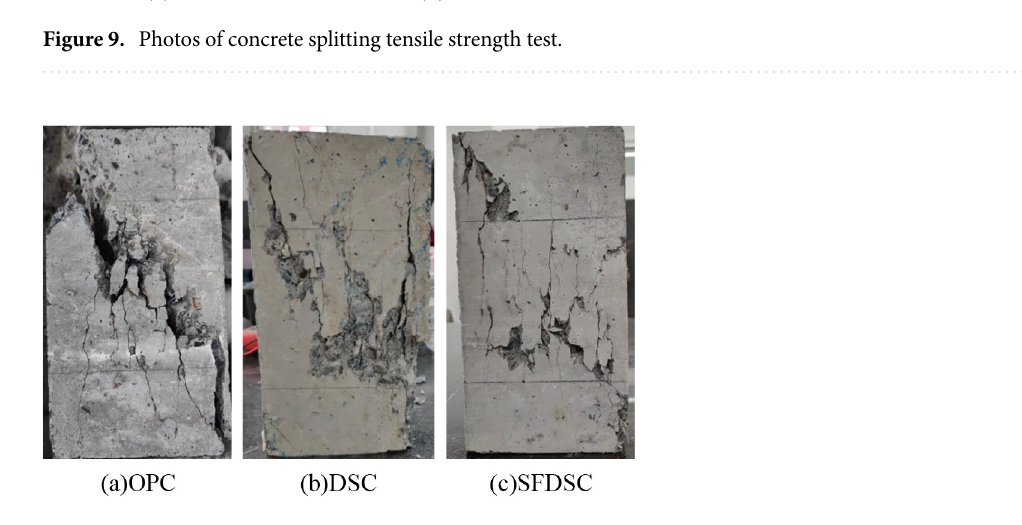
Figure 10. Photos of concrete axial compressive strength